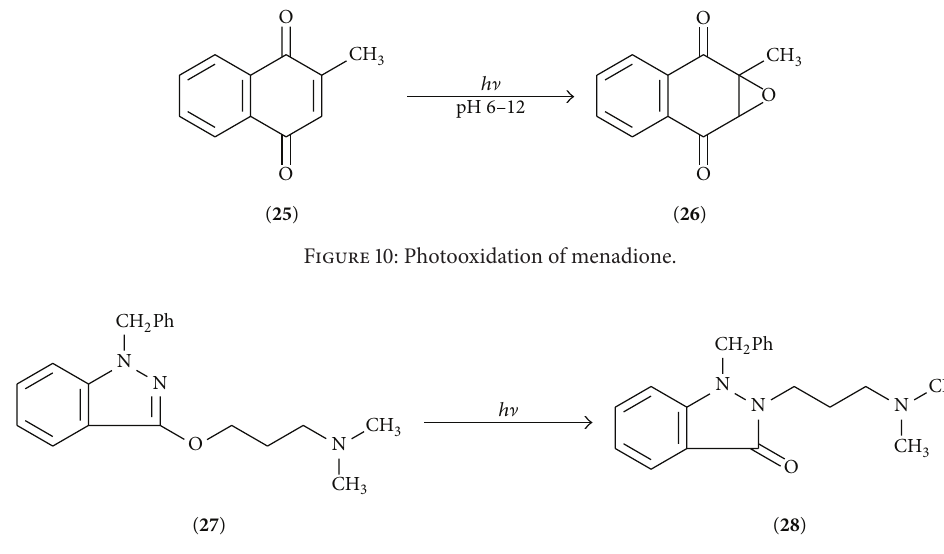
Figure 11: Photoinduced rearrangement reaction of